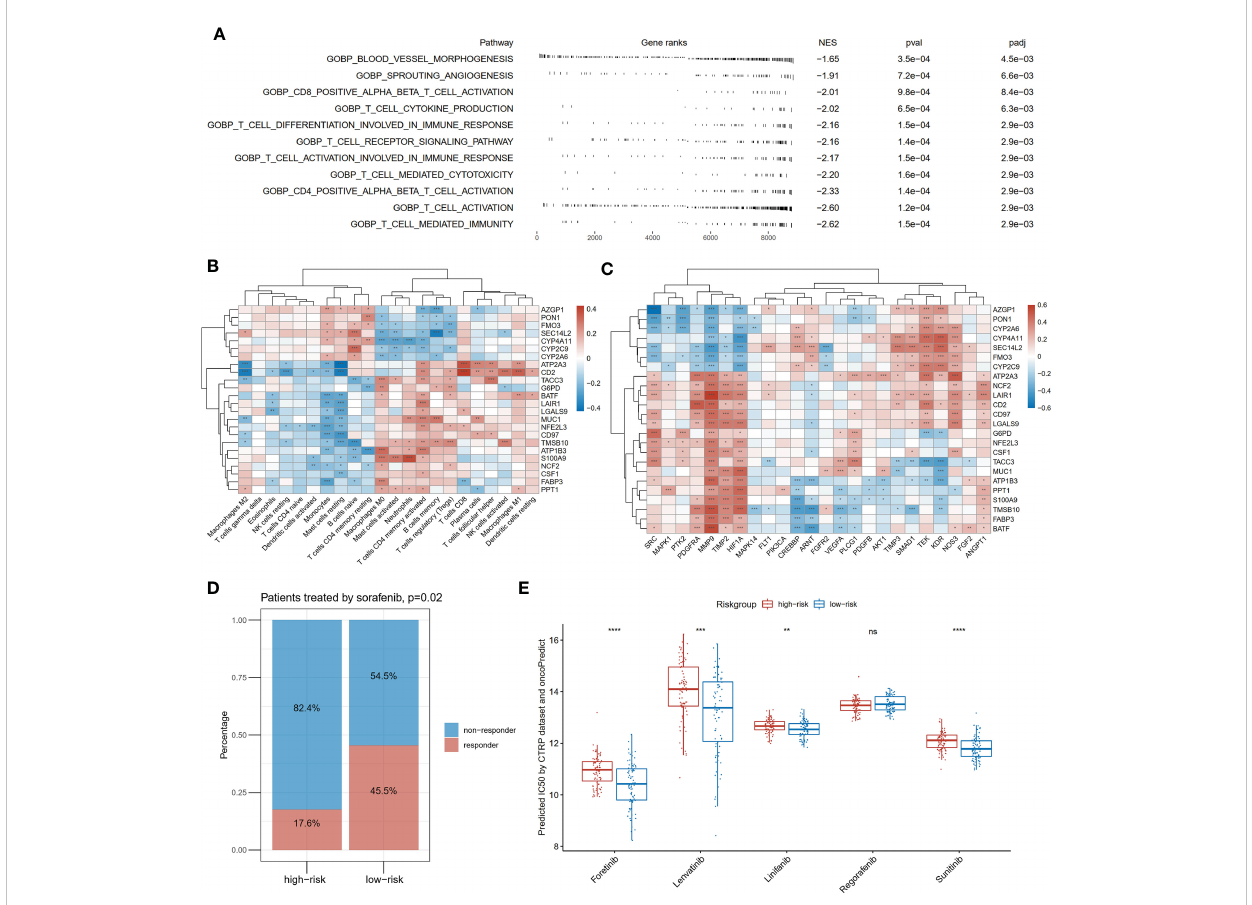
FIGURE 7 Differences in immunity and angiogenesis between high and low risk groups. (A) Two angiogenesis-related pathways and nine immune-related pathways were signi fi cantly enriched in the low-risk group by GSEA. NES means normalized enrichment score; (B) The heatmap of the correlation between the expression of the twenty-four genes constituting the risk model and the degree of immune in fi ltration; (C) The heatmap of the correlation between the expression of the twenty-four genes constituting the risk model and angiogenesis-related genes; (D) Comparison of response rates to sorafenib in high- and low-risk groups in GSE109211; (E) Drug sensitivity prediction of anti-angiogenic drugs except for sorafenib by oncoPredict based on the CTRP (Cancer Therapeutics Response Portal) database, *P<0.05; **P<0.01; ***P<0.001;